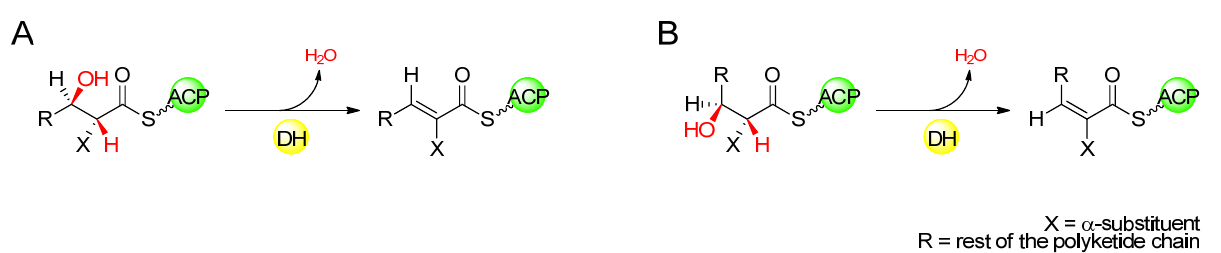
Figure 10. ( A ) DH-catalysed syn dehydration of a (3 S )-hydroxyacyl intermediate, forming a trans ∆ 2 -acyl intermediate. ( B ) DH-catalysed syn dehydration of a (3 R )-hydroxyacyl intermediate, forming a cis ∆ 2 -acyl